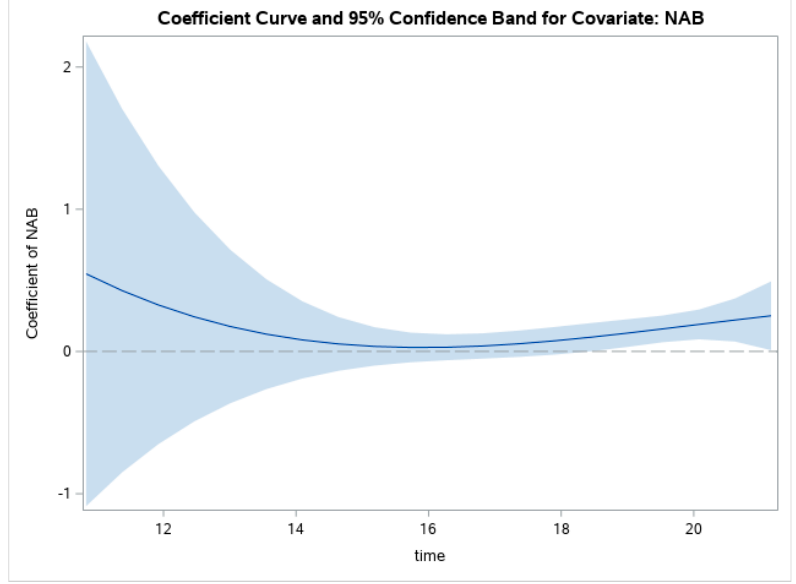
Figure 2. Changes in relations between SAB and GHQ through adolescence.